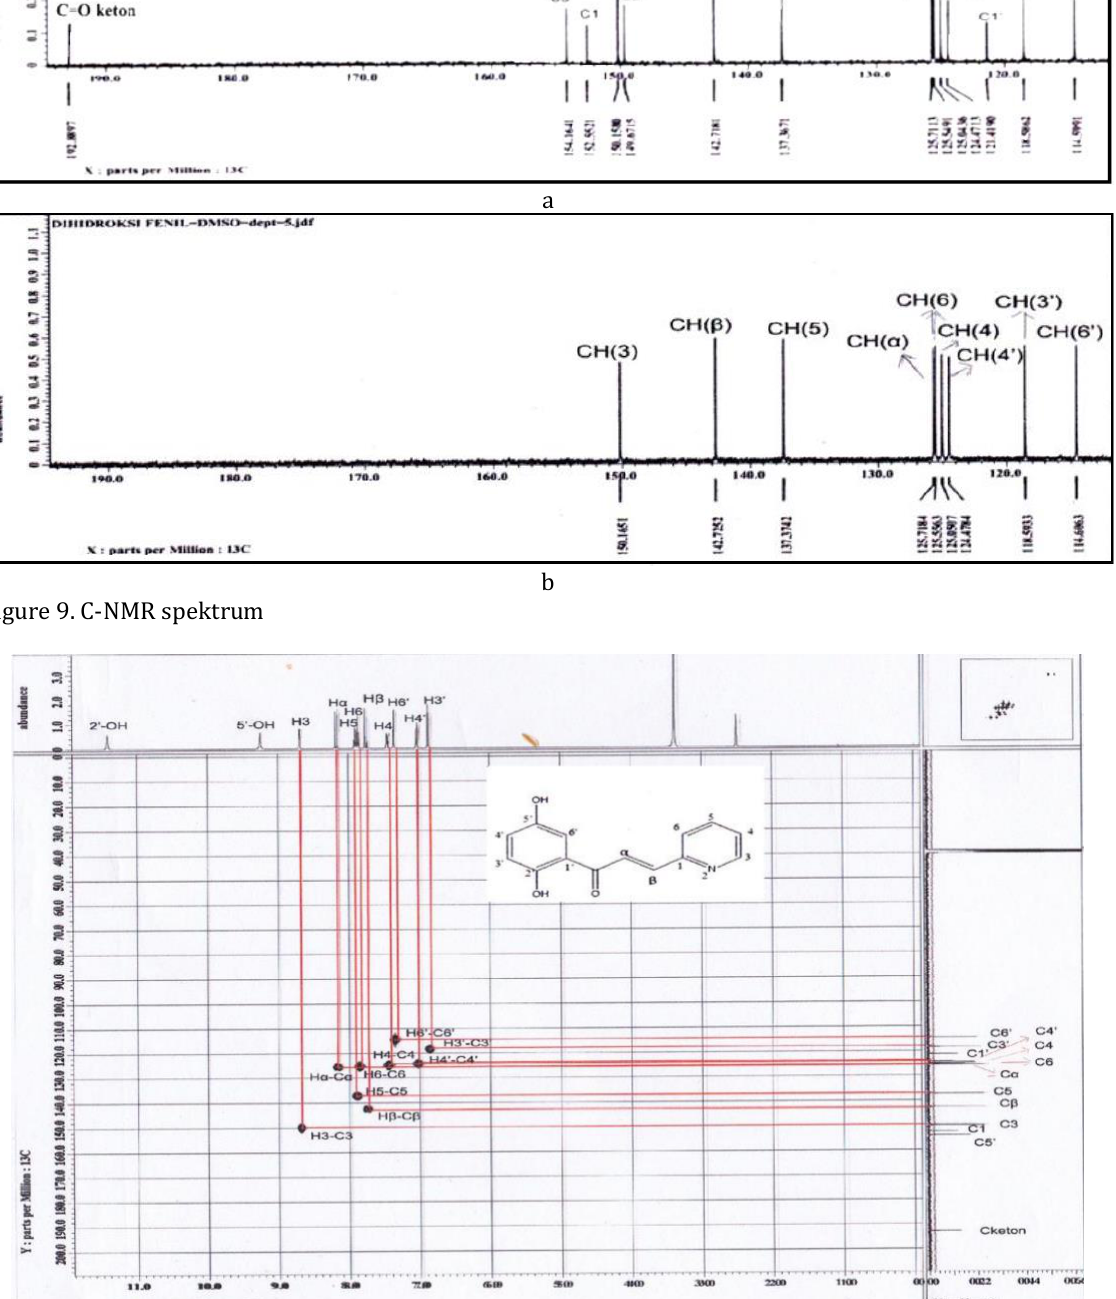
Figure 10. The COZY